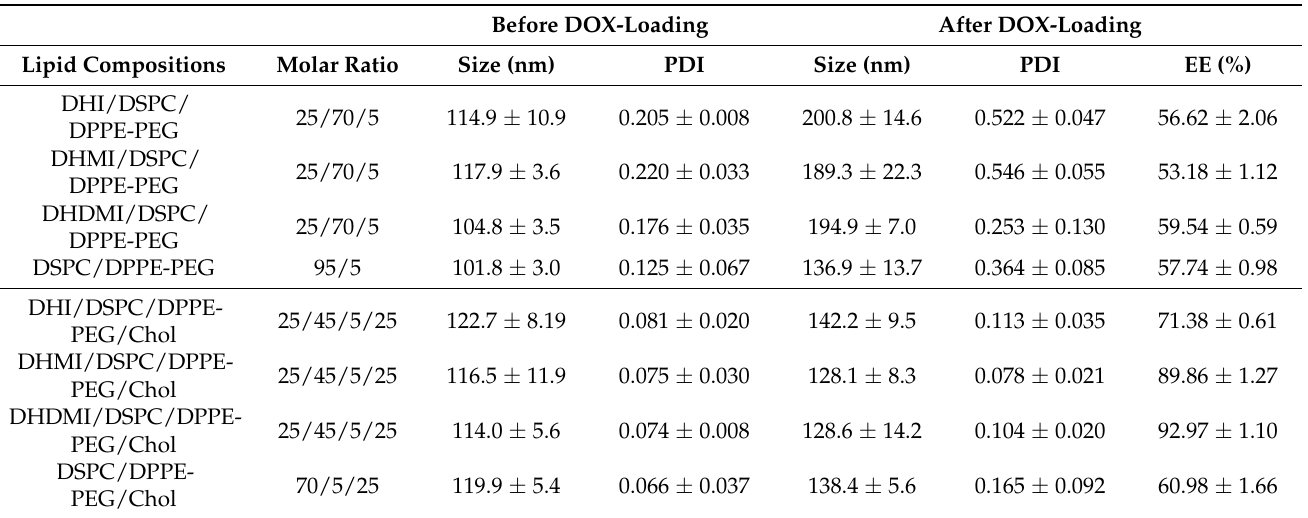
Table 1. Physicochemical characteristics of DOX-free and DOX-loaded ICL in comparison with pH-insensitive stealth